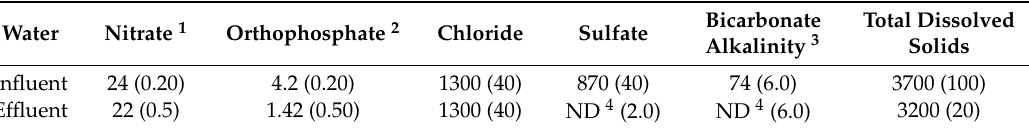
Table 4. Comparison of select anion concentrations (in mg/L) in CT blowdown influent and last